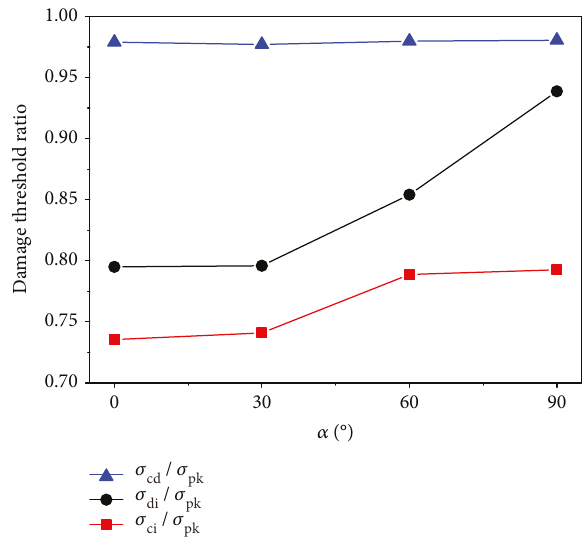
Figure 13: Damage threshold ratios of pre fl awed specimens under unloading